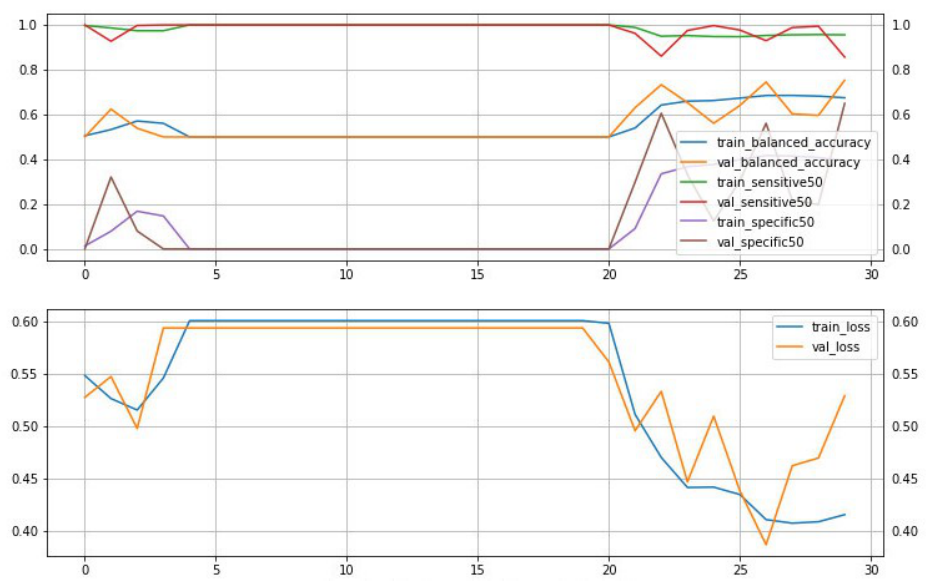
Figure 2. Getting in the trap and then getting out after machine learning epochs. “Cat vs. not-cat” problem on CIFAR-10, trained with VGG16 and the “broken loss” function (34). While in the trap, the machine takes every image for a cat (sensitivity = 1, specificity = 0 at threshold σ =